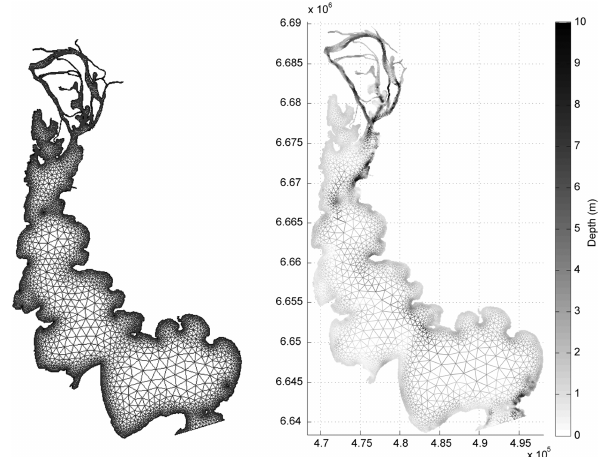
Fig. 3. Spatial discretization of the Guaíba River using an orthogo- Fig.3: SpatialdiscretizationoftheriverGua´ıbausinganorthogonaltriangulargrid(a)anditsbathymetry(b). nal triangular grid (a) and its bathymetry (b)